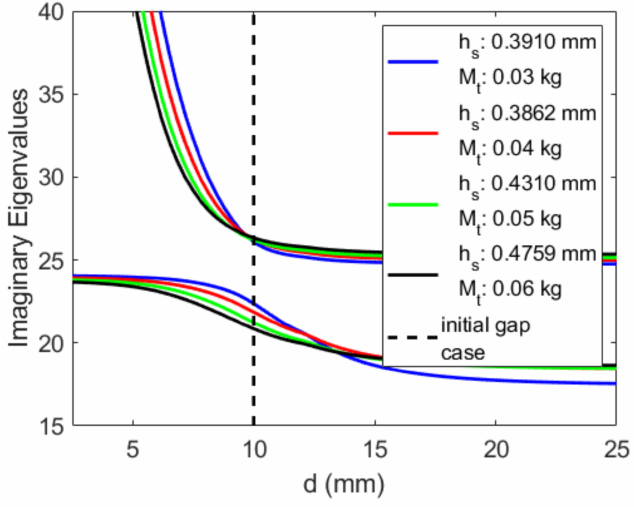
Figure 23. The initial gap’s effects on the coupled natural frequency of varying tip masses with its paired substrate